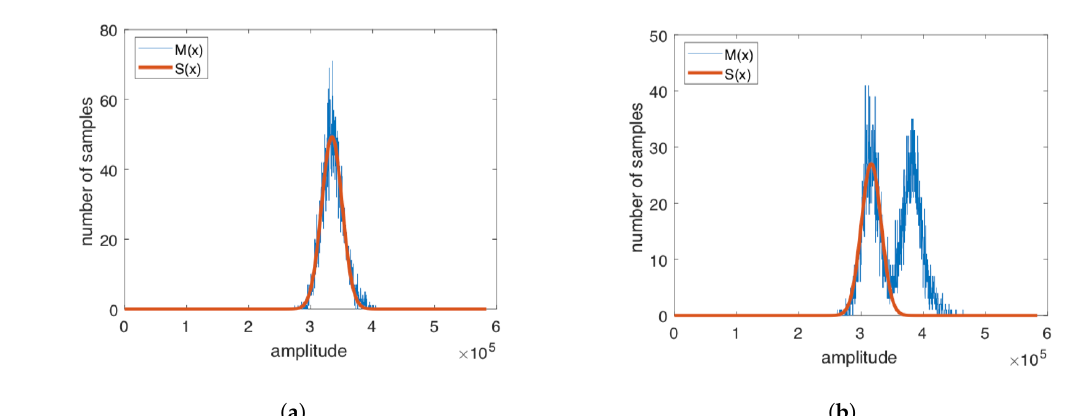
Figure 8. Change of the distribution in the presence of scintillations. ( a ) best fitting Gaussian distribution in absence of scintillations; ( b ) histogram of the samples for a time window including both samples affected by scintillations and not affected. A Gaussian best fitting would be able to match only the “non-scintillated” part of the